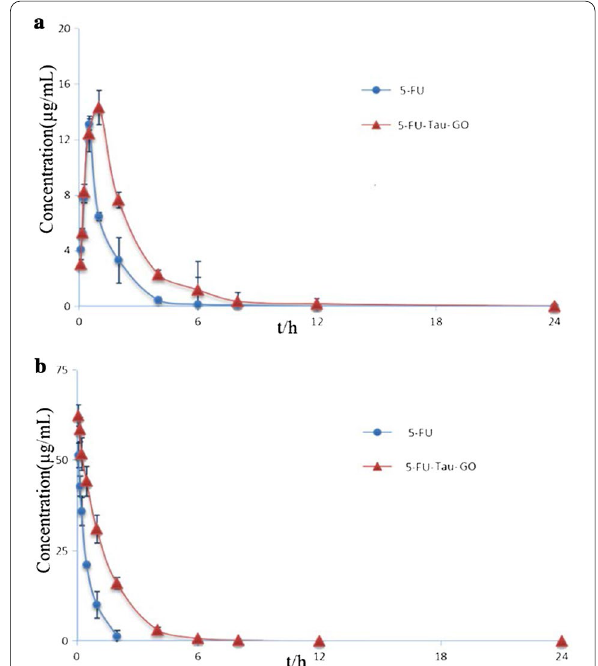
Fig. 13 In vivo pharmacokinetic standard curves of 5-FU and 5-FU-Tau-GO through oral administration ( a ). In vivo pharmacokinetic standard curve of 5-FU and 5-FU-Tau-GO through intravenous injection ( b